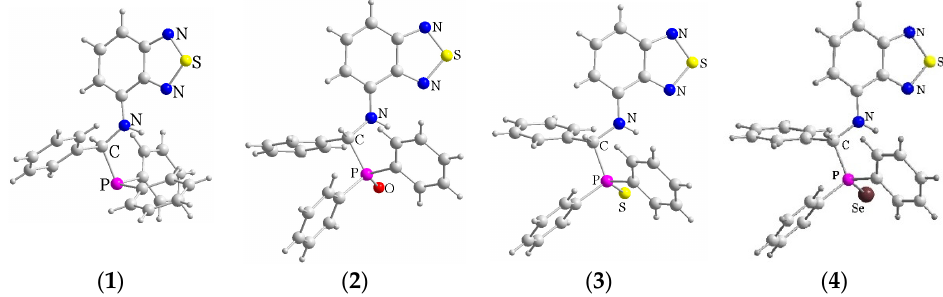
Figure 2. Crystal structures of 1 – 4 . For 2 , the molecule of compound 2 α is represented.